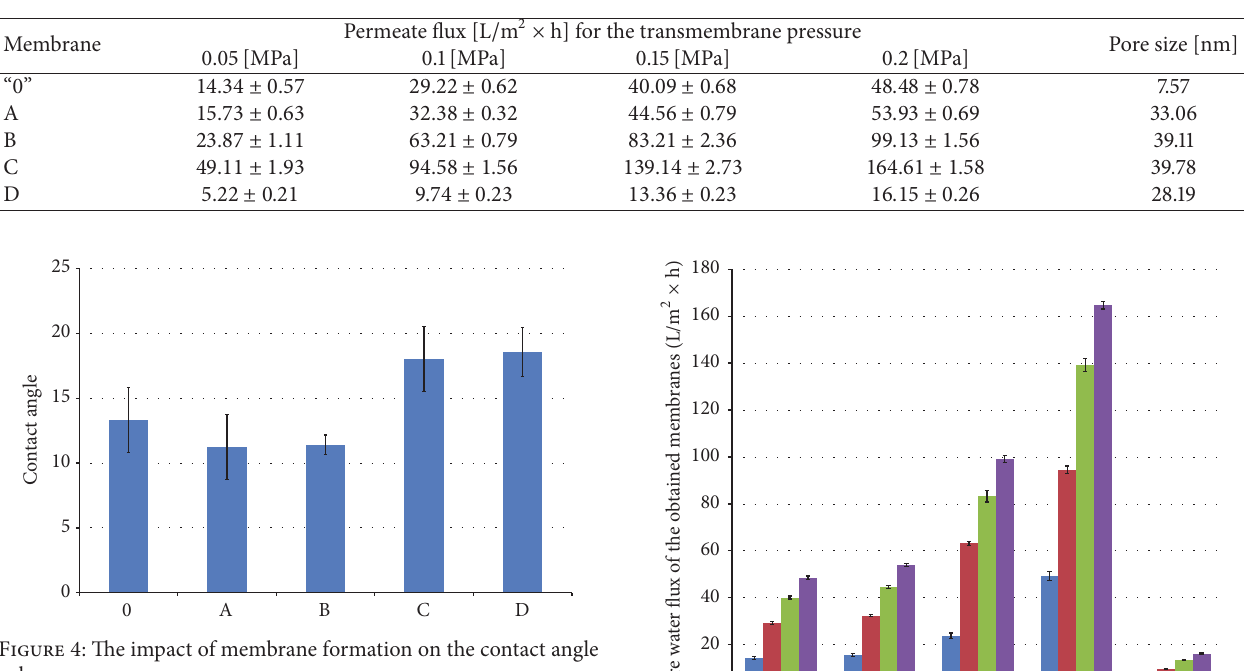
Table 2: Permeate flux and pore sizes of membranes.